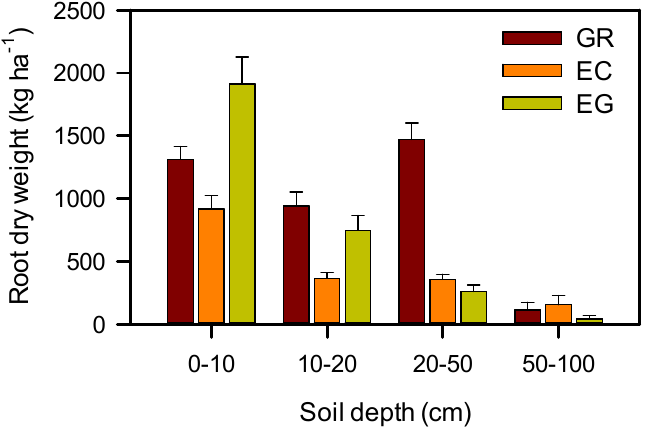
Figure 4. Mean standing root dry weight by soil depth. Species include giant reed (GR), energycane (EC), and elephantgrass (EG). Error bars represent 1